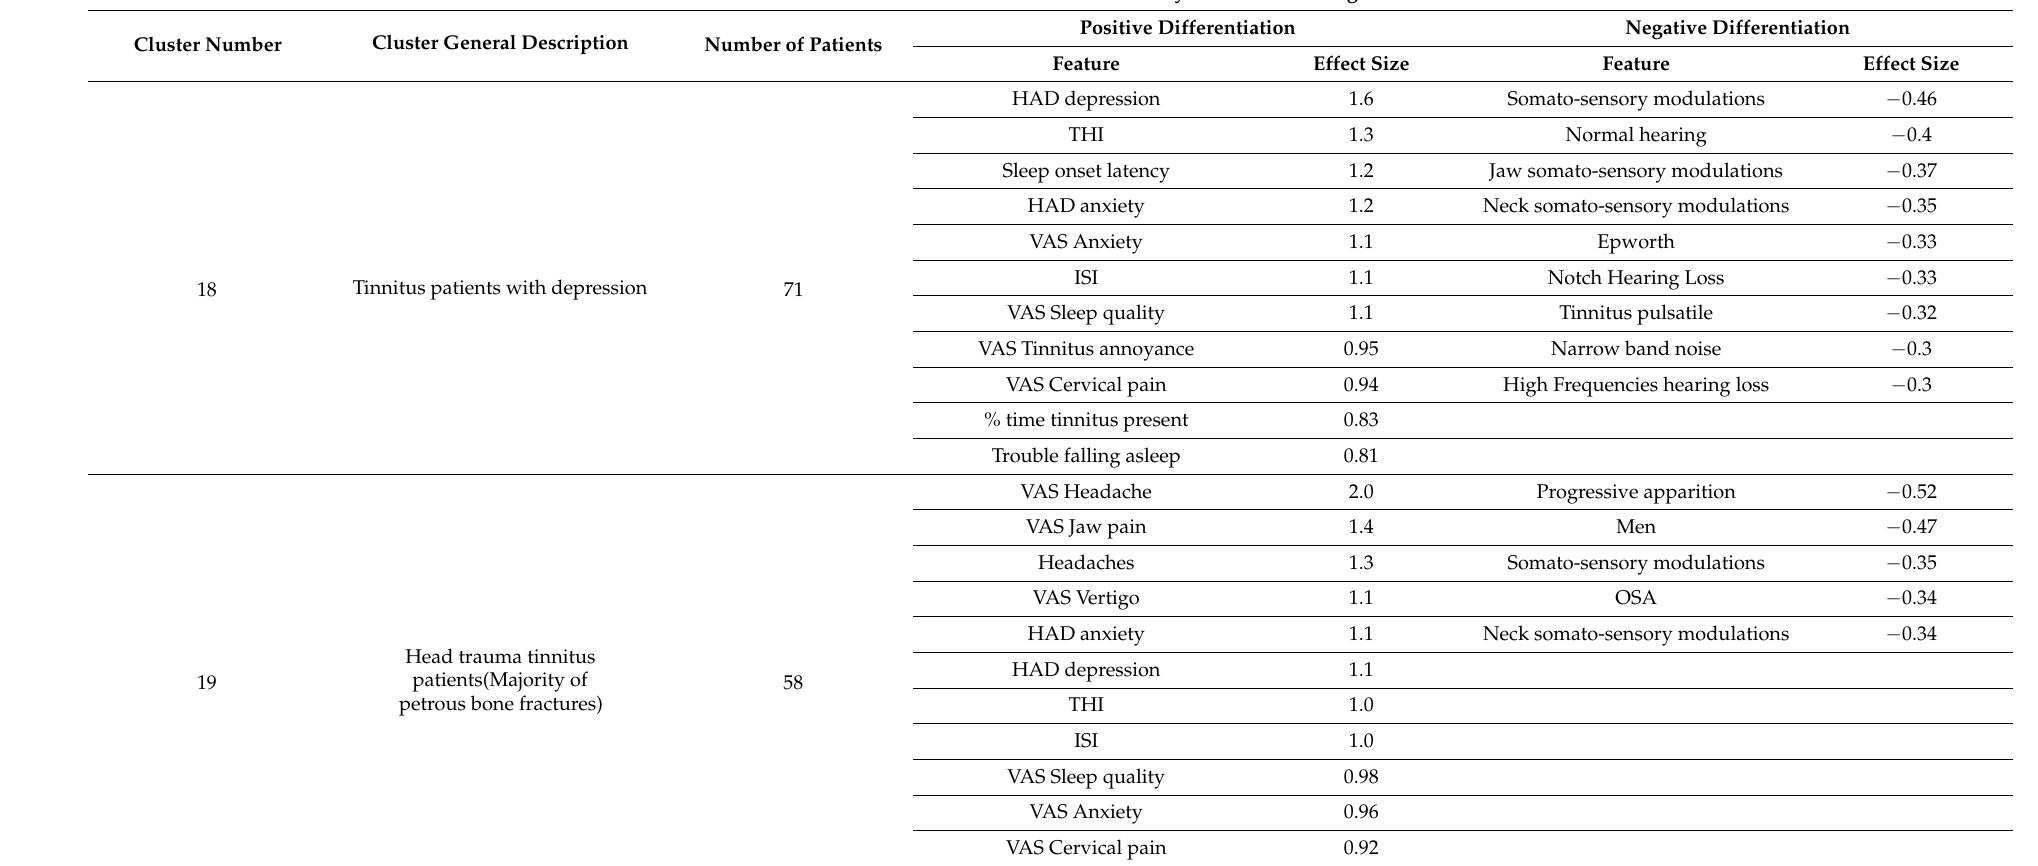
Table 7. Cont. Individual Clusters Characteristics of the Finally Selcted